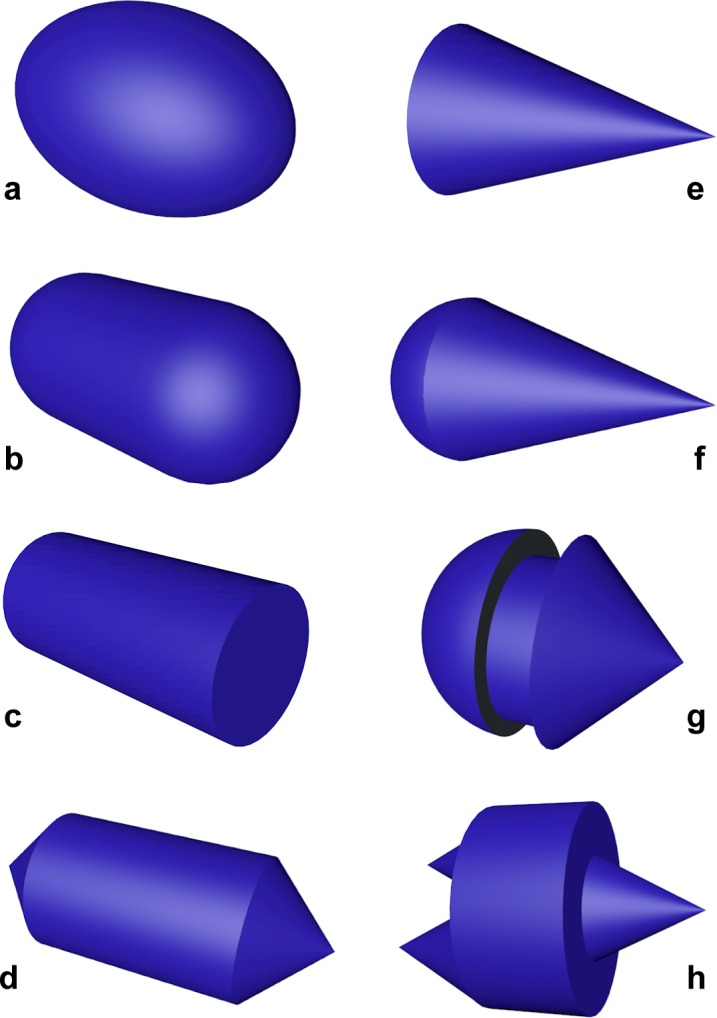
Simple or composite geometric shapes used as models for testing the accuracy of the proposed method.(a) prolate spheroid, (b) cylinder with hemispherical ends, (c) cylinder, (d) cylinder with conical ends, (e) cone, (f) cone with a hemispherical end, (g) Peridinium-like, (h) Ceratium-like. The latter two shapes are named after two common microalgae genera.